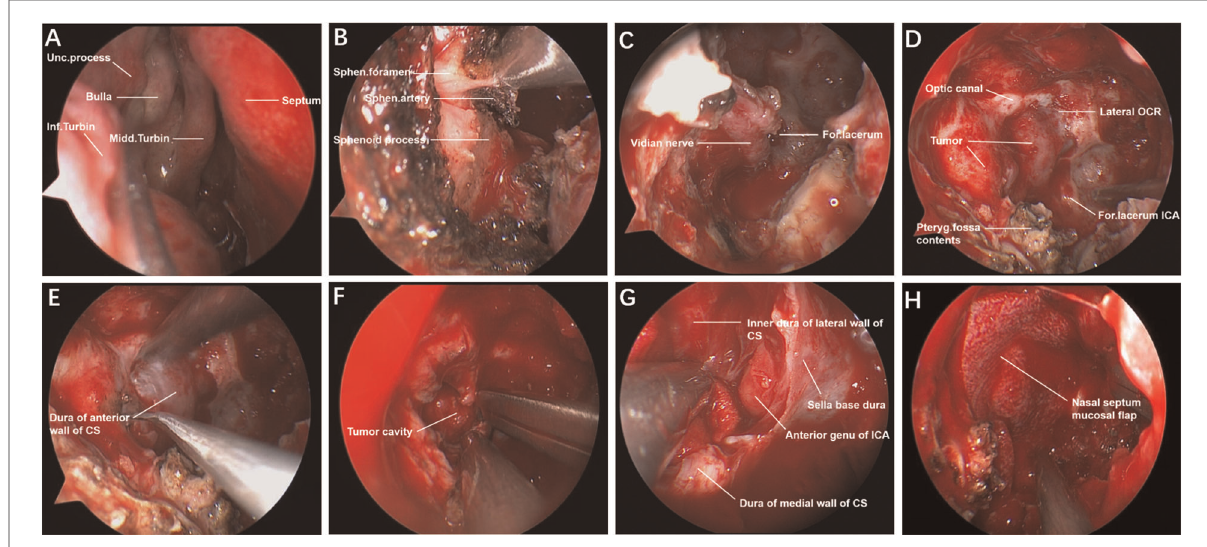
FIGURE 2 Endoscopic endonasal transpterygoid approach to resect intracavernous HPC. The normal structures of the nasal cavity in the endoscopic view ( A ). The sapopalatine artery from the sphenopalatine foramen was exposed and cut off ( B ). Drilling the vidian canal and exposing the vidian nerve, ICA from foramen lacerum was identi fi ed in the lateral-superior of vidian nerve ( C ). The main anatomical landmarks and the tumor were exposed by stepwise bone resection ( D ). Incision of dura mater of the anterior wall of the CS ( E ). The tumor was removed piece by piece under the endoscope ( F ). Overall view of the surgical area after total tumor resection ( G ). The operation area was covered by a nasal septum mucosal fl ap to prevent cerebrospinal fl uid leakage ( H ). Unc., uncinate; Inf., inferior; Midd., middle; Turbin., turbinate; Sphen., sphenopalatine; For.,